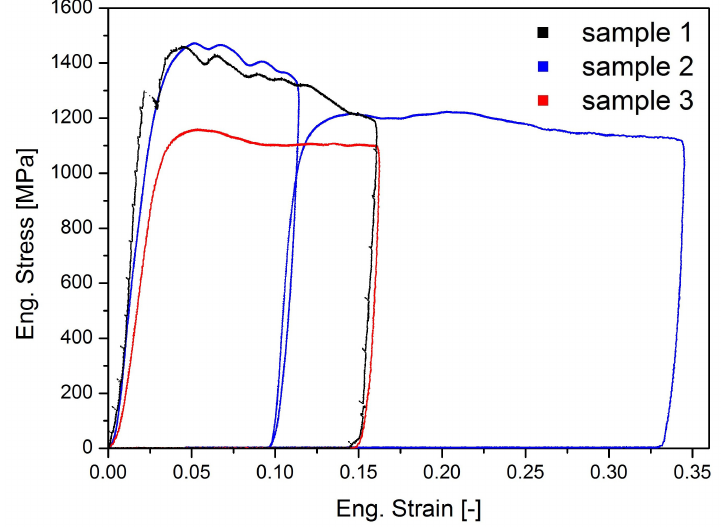
Figure 2. Stress-strain data of all three samples. Sample 2 was compressed twice in order to study larger amounts of